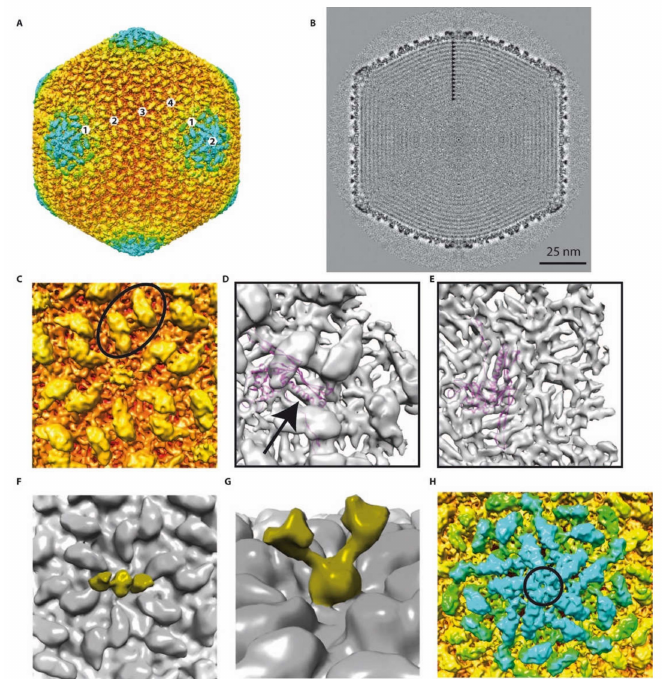
Figure 3. Detailed 3D reconstruction of the phAPEC6 capsid: ( A ) Isosurface representation of the phAPEC6 head 3D reconstruction at a 10-Å resolution. The particle is colored according to its diameter (from red to blue). ( B ) Central slice of the phAPEC6 head visualizing 15 concentric layers of DNA (black arrows). ( C ) Close-up view of one 6-fold axis. The major capsid protein (MCP) is colored in orange and the decoration protein in yellow. The black oval highlights a local 2-fold axis. ( D ) Fitting of the HK97 MCP X-ray structure into the phAPEC6 hexamer density seen from the outside of the particle (an arrow highlights the long alpha helix present in both HK97 and phAPEC6 MCP) and ( E ) seen from the inside of the particle. ( F ) Detail of the hexamer central protein along a 2-fold axis, displaying the fiber-anchoring protein. ( G ) Side view of the fiber-anchoring protein. ( H ) Close-up view of the 5-fold axis. The pentamer is colored in blue and highlighted by a black circle. The same protein as the one colored in yellow in part C is visible around the 5-fold